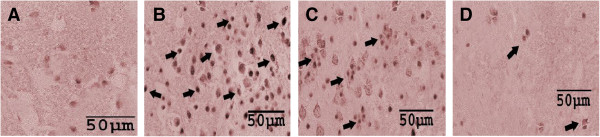
Immunohistochemical expression pattern of Bax in striatum. A: Control (group1); B: MPTP induced (group II); C: MPTP induced + As treated (group III); D: Drug Control (group IV).